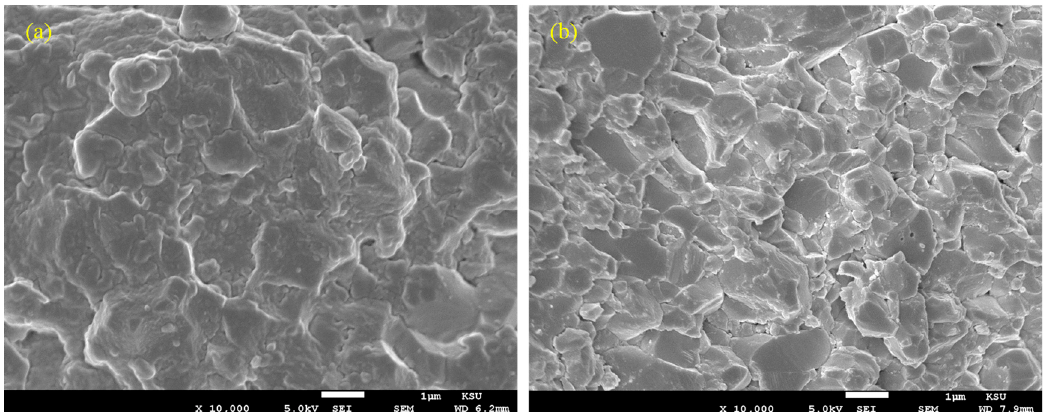
Figure 6. SEM images showing the fractured surfaces of ( a ) base Al 2 O 3 ; ( b ) 1.5 wt.% GNP/Al 2 O 3 .